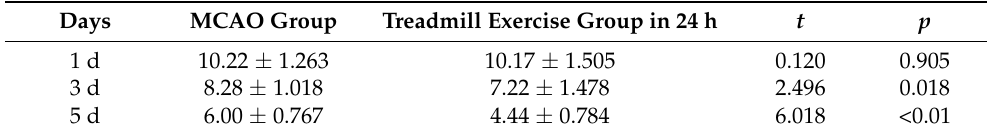
Table 5. The mNSS score of rats in the 24 h treadmill exercise after MCAO ( x ± s). Days MCAO Group Treadmill Exercise Group in 24 h